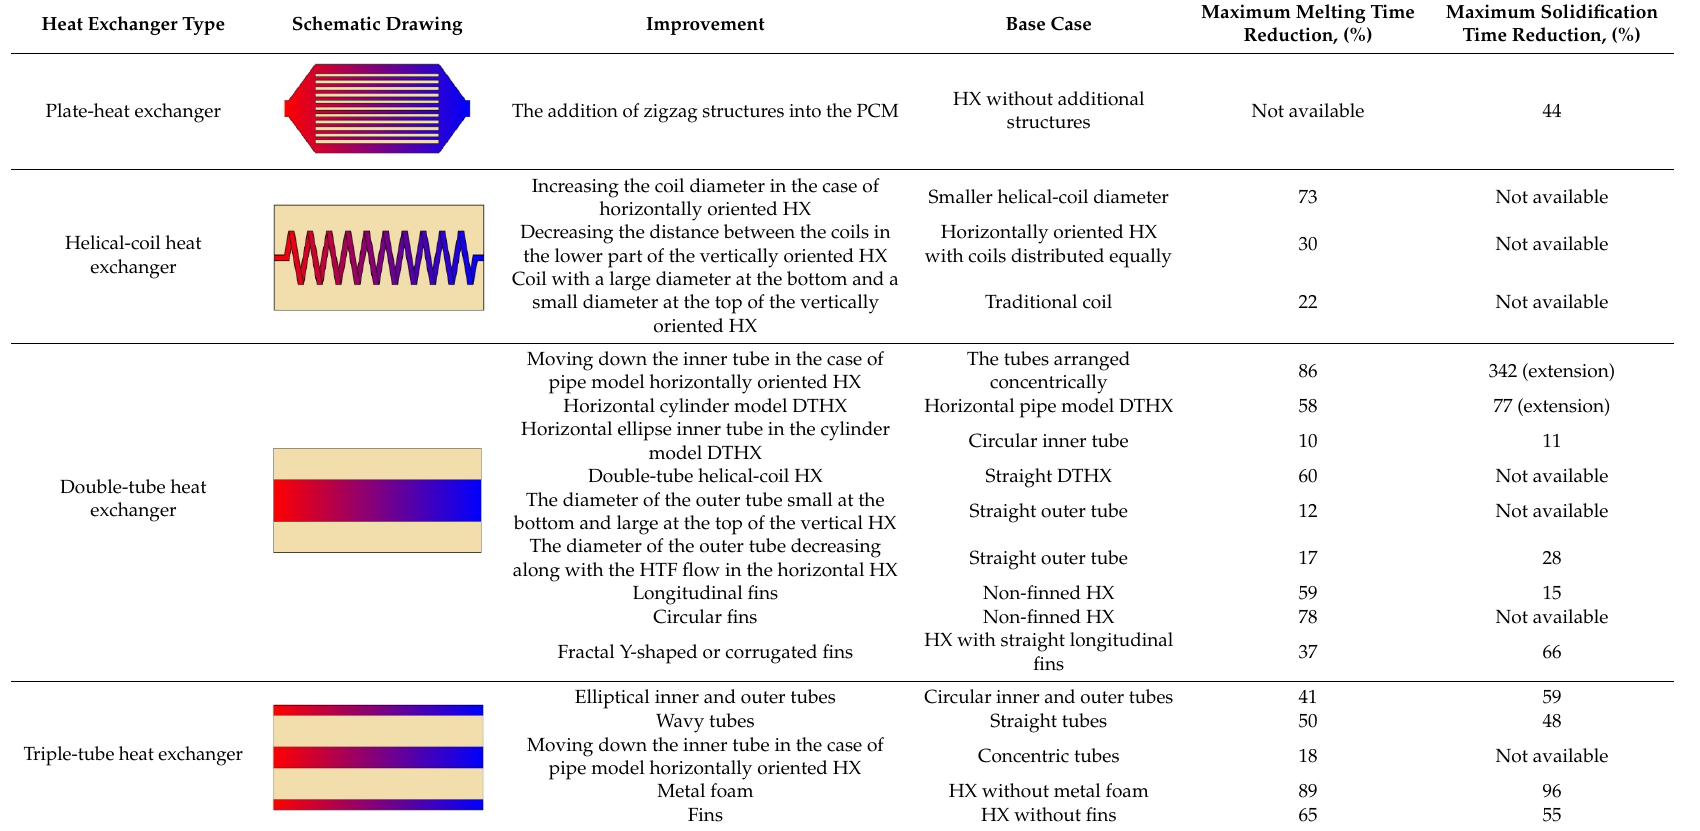
Table 10. Types of heat exchangers for PCMs and the main possibilities of phase change time reduction.